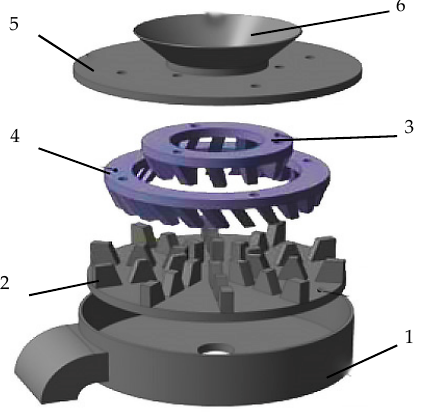
Figure 2. Grain shredder of centrifugal-rotary type with a knife working body (own study based on [4–6]): 1—housing; 2—lower disk-rotor; 3—ring of the first degree of grinding; 4—second-degree grinding ring; 5—cover; 6—receiving chamber.